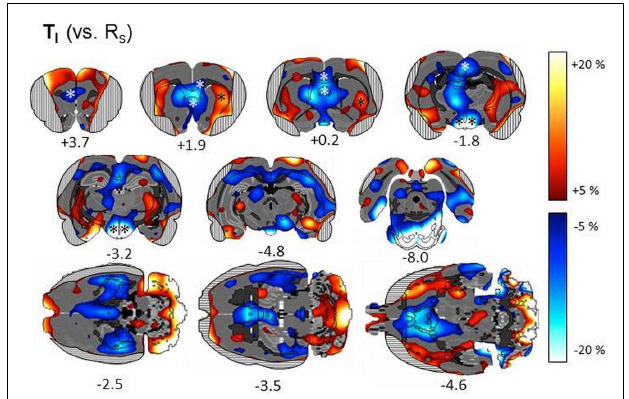
FIGURE 5 | Subtractive approach: percent change of metabolic activity in Simon tasks with 100% incompatible trials ( T I ) relative to resting state ( R S ). Grand average from n = 7 animals with mean changes projected onto transverse and horizontal sections of a master brain. Coordinates are mm from Bregma. Areas obscured by muscle artifacts are masked and significantVOIs are indicated by asterisks.